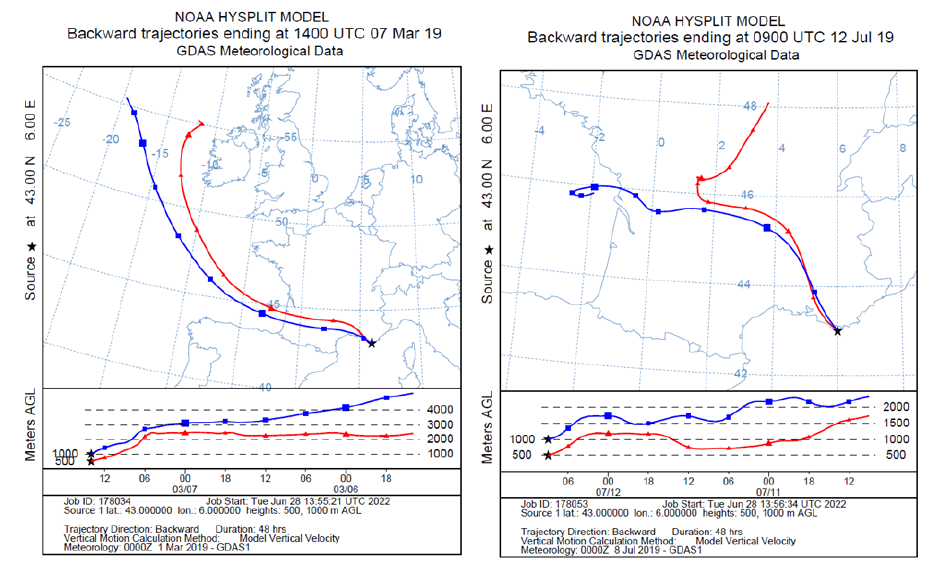
Figure 2. Air mass backtrajectories recorded during aerosol samplings made on the island of Porquerolles in March 2019 (P1, left )) and July 2019 (P2, right ).